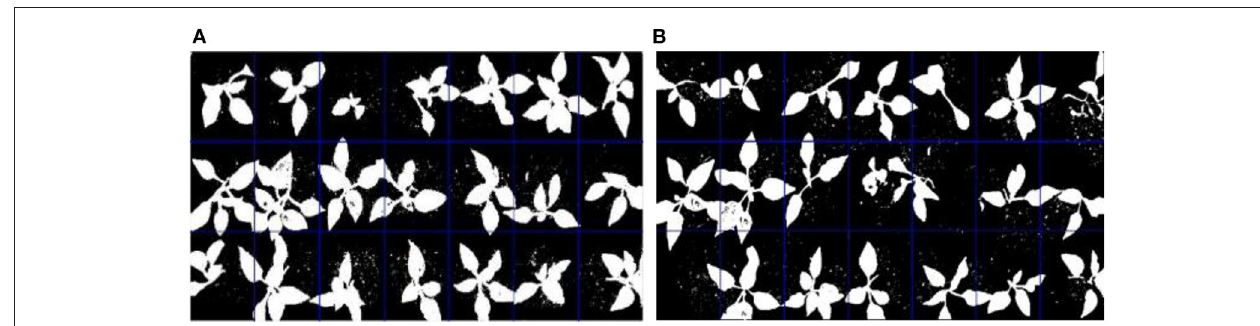
FIGURE 5 | Threshold segmentation by the optimal threshold method.